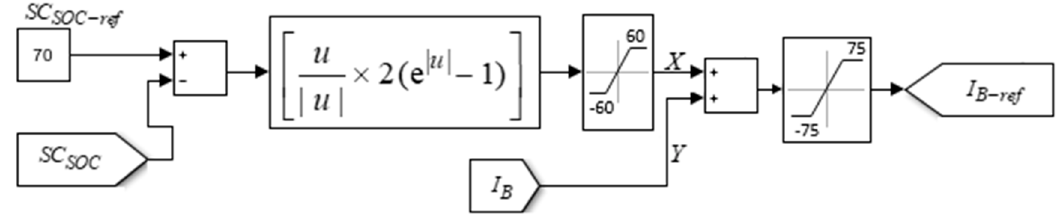
Figure 11. SC Charge controller.